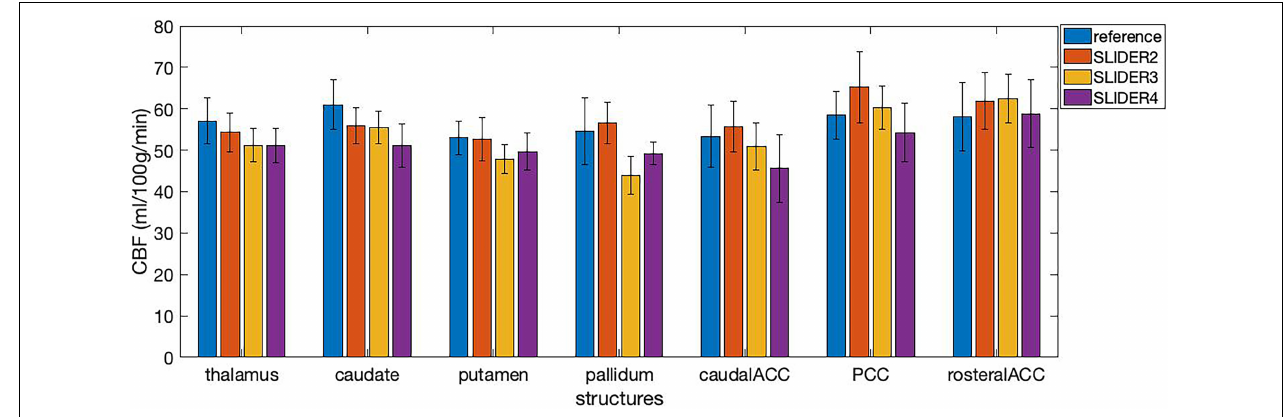
FIGURE 7 | Cerebral blood flow values in seven small brain structures acquired under different SLIDER and reference conditions. ACC, anterior cingulate cortex; PCC, posterior cingulate cortex. Error bars stand for stand deviation.